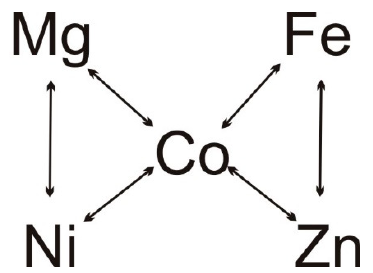
Figure 12. Schematic representation of dominant cationic substitutions within the arsenate series of vivianite-group minerals.